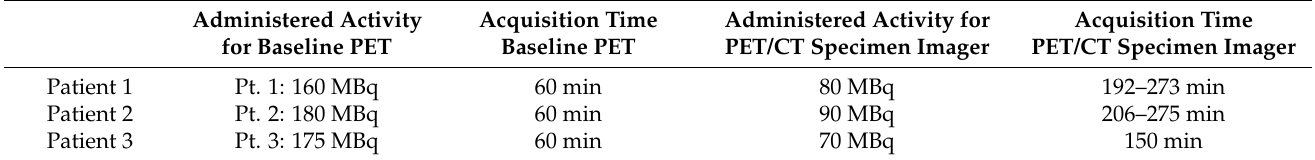
Table 2. Administered activity and acquisition time differences between standard whole-body PET/CT scans and PET/CT specimen imager scans in each